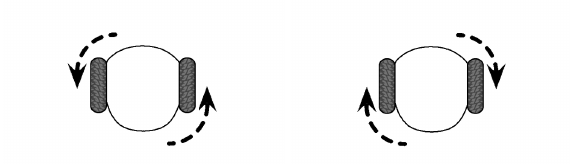
Fig. 9. Rotation animated vector indicators